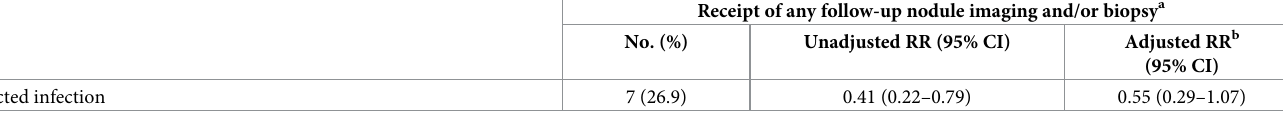
Abbreviations: CCI, Charlson Comorbidity Index; RR, relative risk; ZCTA, zip code tabulation area. a Using Poisson regression with robust error variances. b Adjusted models included all patient and nodule characteristics except life expectancy. c Adjusted model for life expectancy included all patient and nodule characteristics except age and CCI. d Test for linear trend P < 0.05.